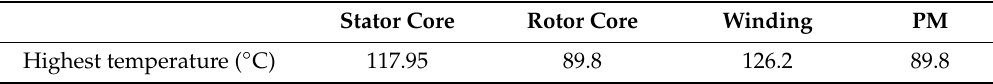
Table 7. The highest temperature of each component.